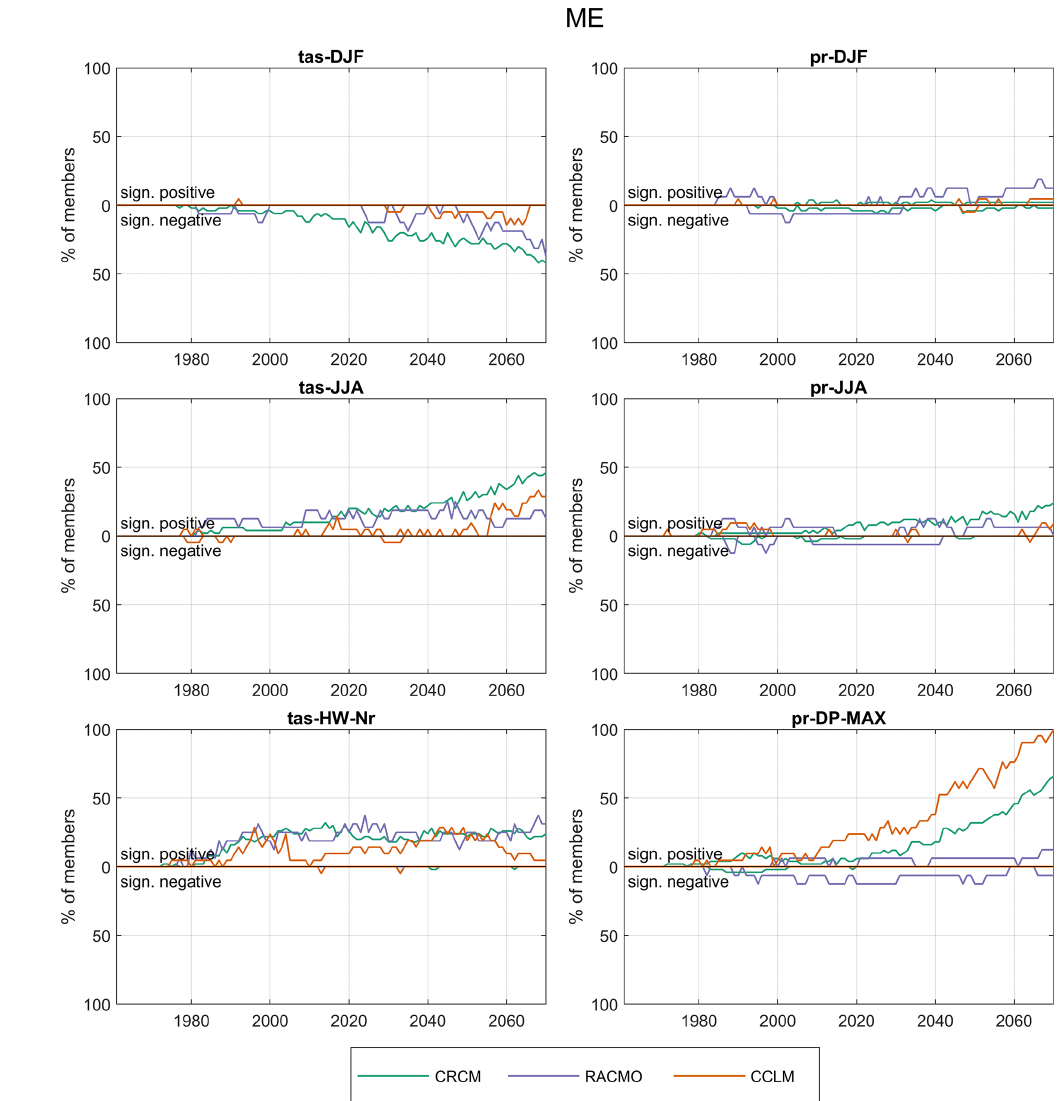
Figure 8. Percentage of members with significantly different variance (Brown–Forsythe test with α = 0 . 05) with respect to the reference period 1961–1990 in mid-Europe. The analysis is based on residuals after removing the EM from each member. The years on the x axis denote to the starting year of moving 30-year